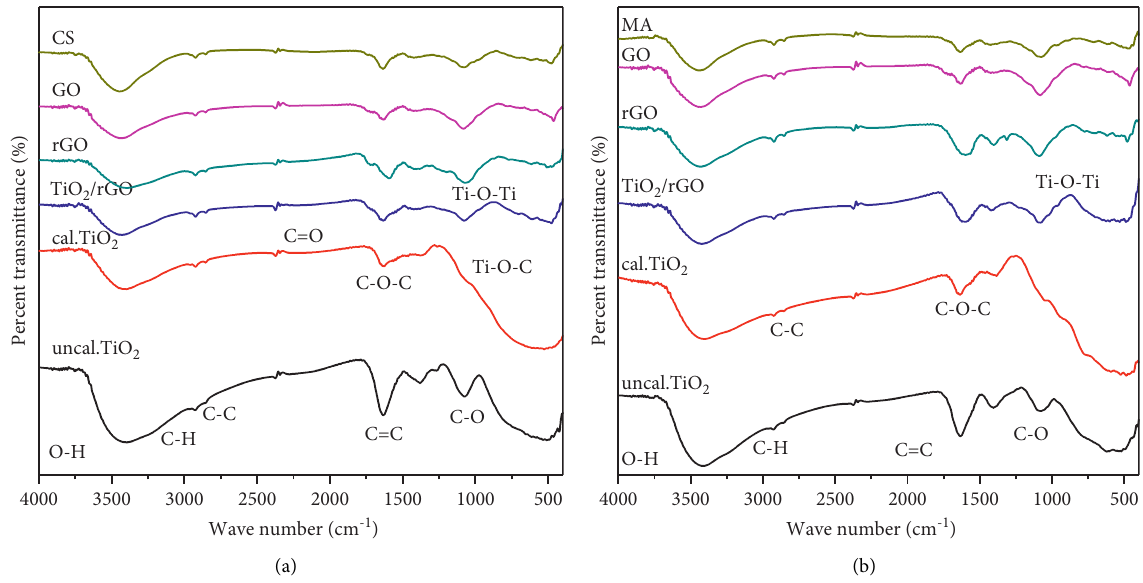
Figure 8: FTIR spectra of (a) Citrus sinensis , Citrus sinensis template synthesized GO, rGO, TiO Musa acuminate template synthesized GO, rGO, TiO 2 , and TiO 2